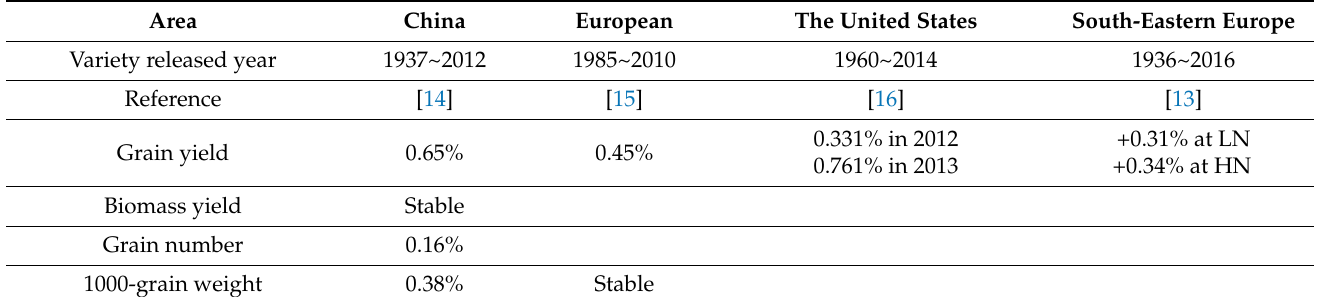
Table 1. The rates of genetic gain (% per year) for yield- and N-use-related traits in wheat.